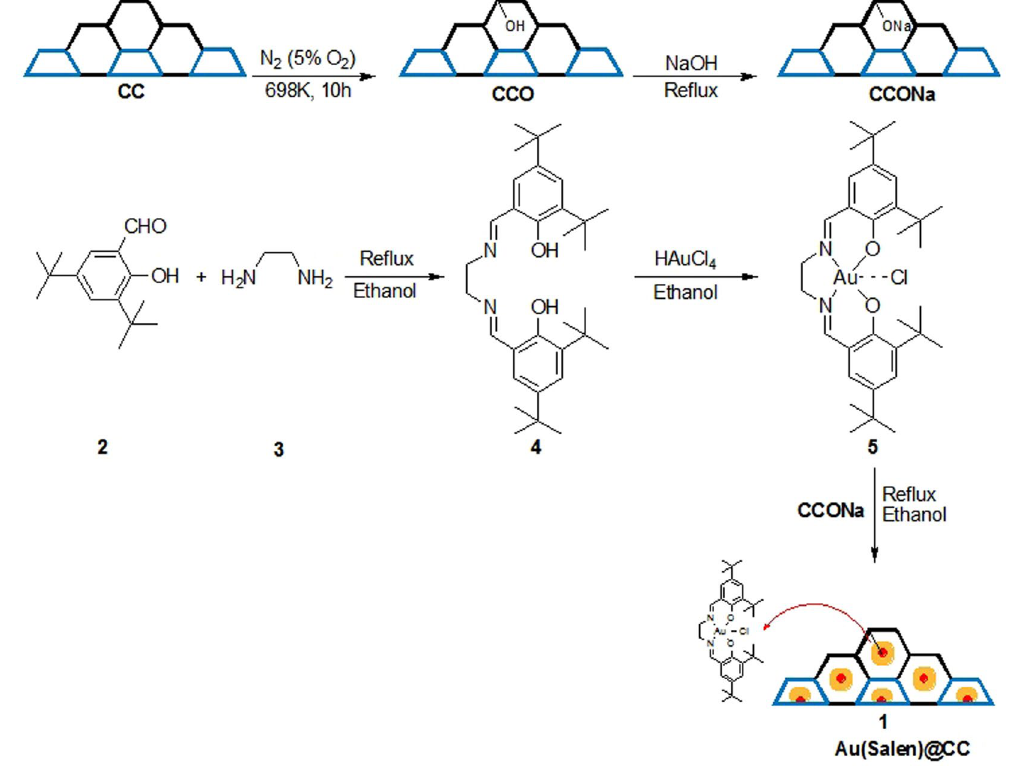
Figure 1. Synthesis route of carbon cage doped nanocomposite Au(Salen)@CC 1 .